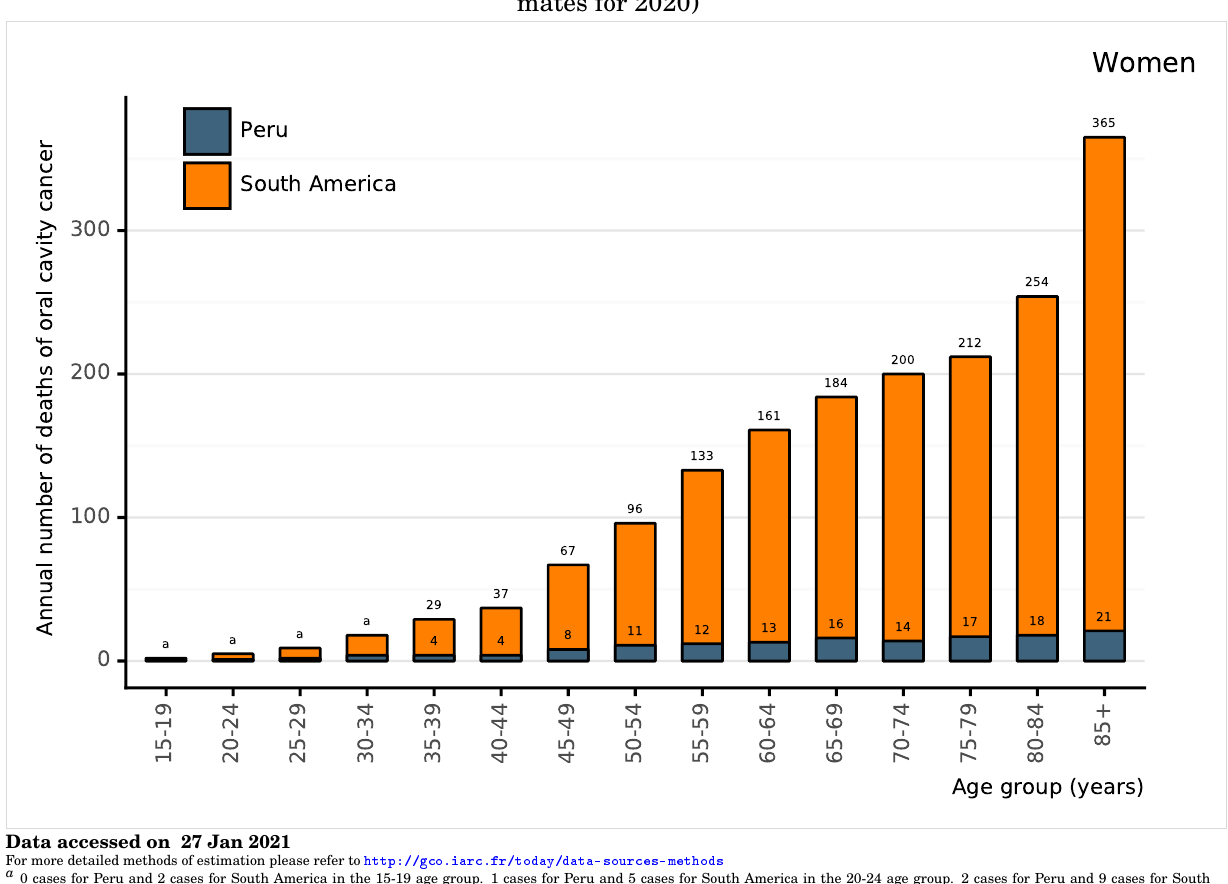
Figure 129: Annual number of deaths of oral cavity cancer among women by age group in Peru